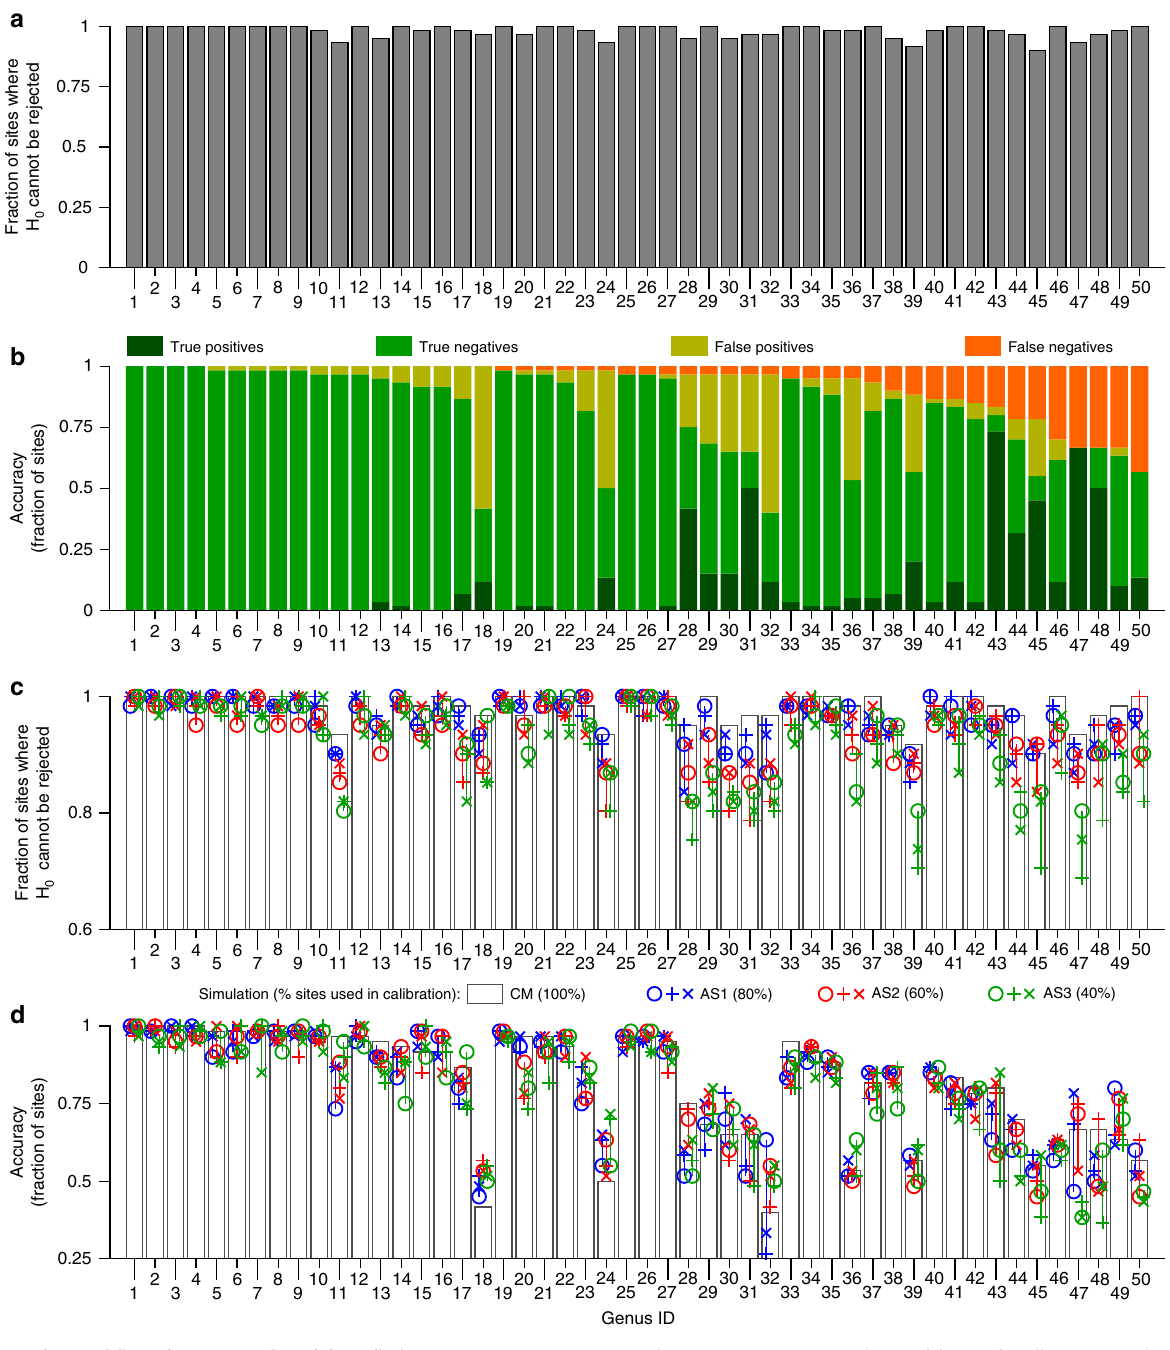
Fig. 7 Goodness of fi t and accuracy of model predictions. Genus IDs are as in Supplementary Data 1. a Goodness-of- fi t test for all genera. In the y-axis label, H 0 is the null hypothesis that the triplet of read numbers evaluated at a site for a given genus comes from a geometric distribution with mean predicted by Eq. (3). b Accuracy of the modeled presence maps with respect to the kicknet sampling for each genus. Genera for which only true negative and false positive sites were identi fi ed are those undetected by kicknet sampling. c , d Goodness of fi t (panel c ) and accuracy (panel d ) of model results as a function of number of sampling sites used in calibration. White bars in panels c and d reproduce the same values as in panels a and b , respectively. Colors identify simulation groups, corresponding to different sizes of calibration subsets. For a given color, each symbol type identi fi es each particular simulation (corresponding to a given calibration subset). Note that identical symbols with different colors do not indicate any relationships among the respective simulations. Colored vertical lines, spanning ranges of variables for each genus and simulation group, are added for visual purposes. Source data are provided as a Source Data fi